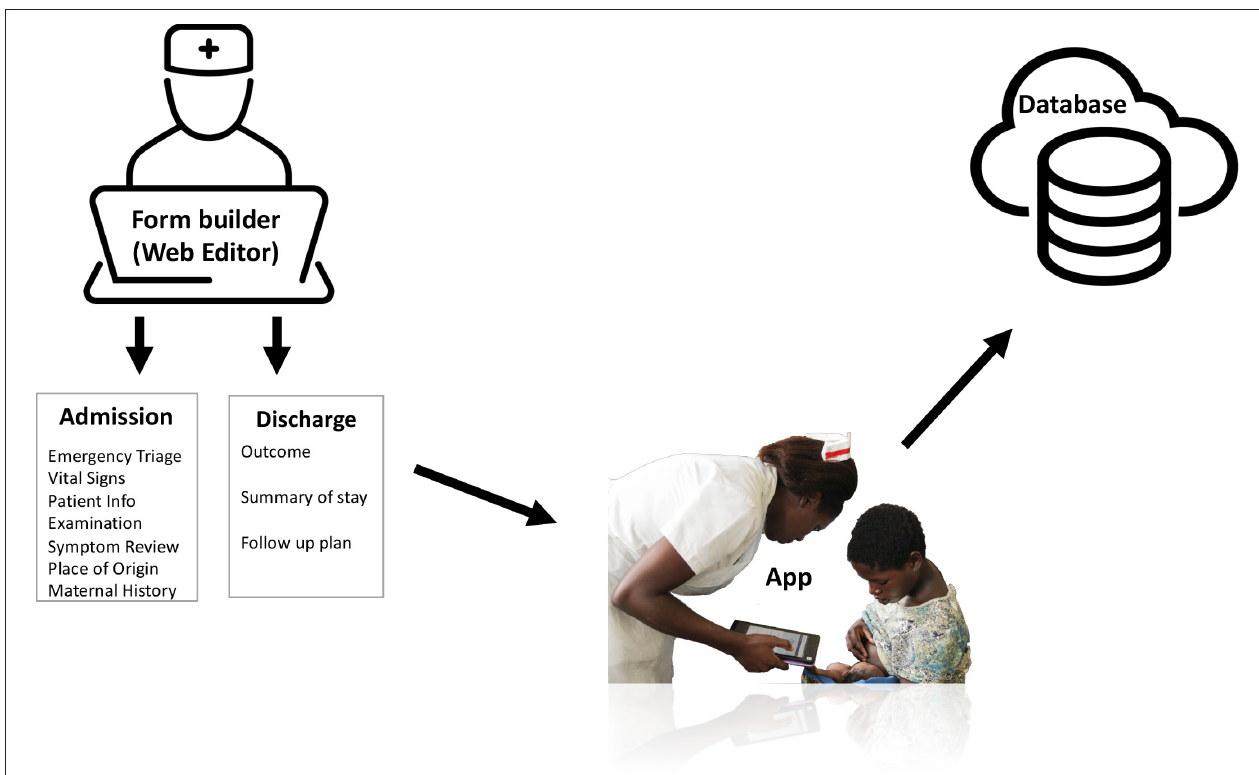
FIGURE 1 | NeoTree system. Copyright 2021 Mgusha et al